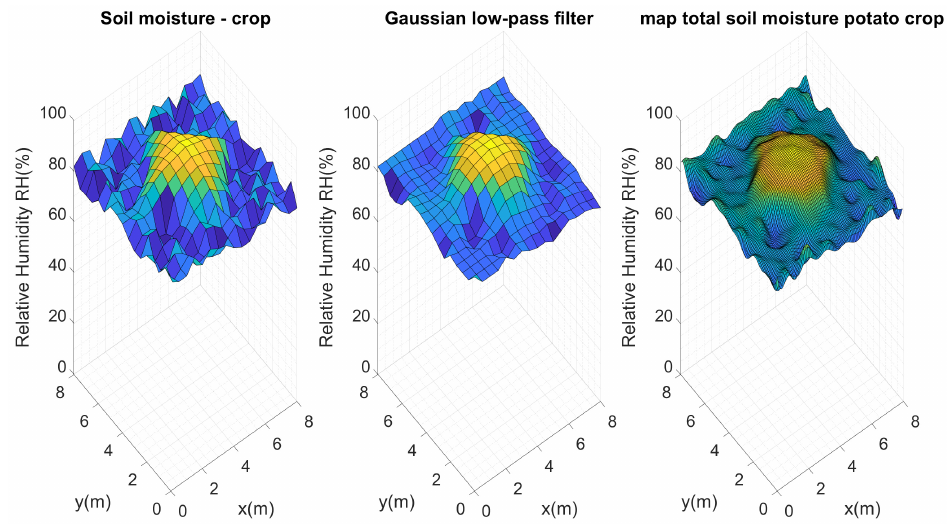
Figure 16. Soil moisture reference map after irrigation in the center of the crop.